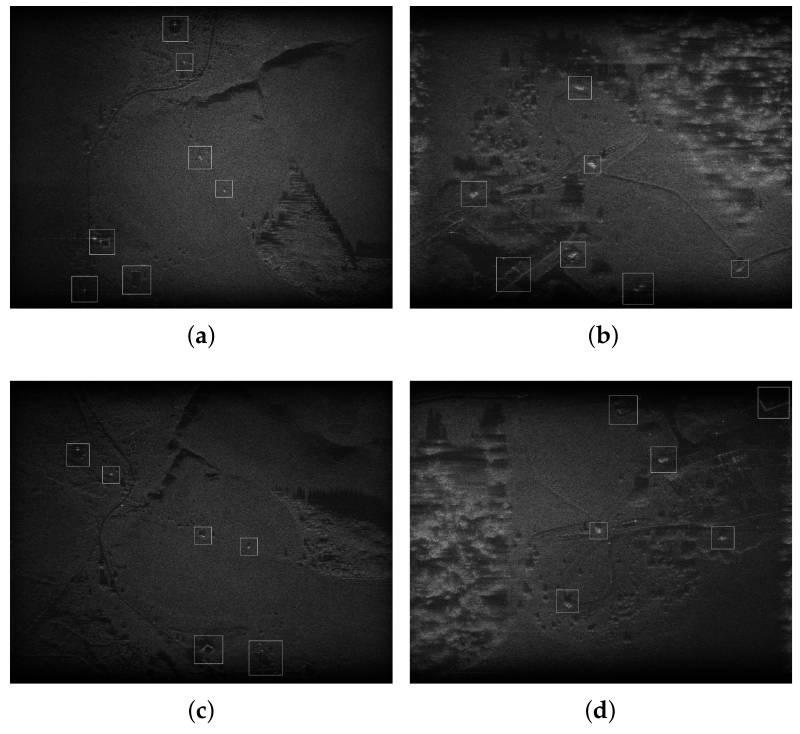
Figure 2. SAR scenes provided from the NATO-SET 250 work group with corresponding bounding boxes around the targets. ( a ) Scene 1 was captured over a large open grass area, it also contains a small portion of trees to the bottom right. ( b ) Scene 2 contains a large collection of trees adjacent to a few man-made structures. ( c ) Scene 3 was captured over a similar region as scene 1 but at a different orientation. This scene highlights more of the tree and hill areas ( d ) Scene 4 is the same area as scene 2 but captured at a different orientation, at this angle more of the forest area is